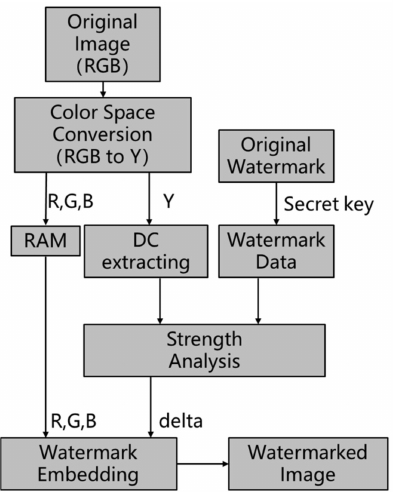
Figure 2. The proposed hidden DCT-based watermarking working